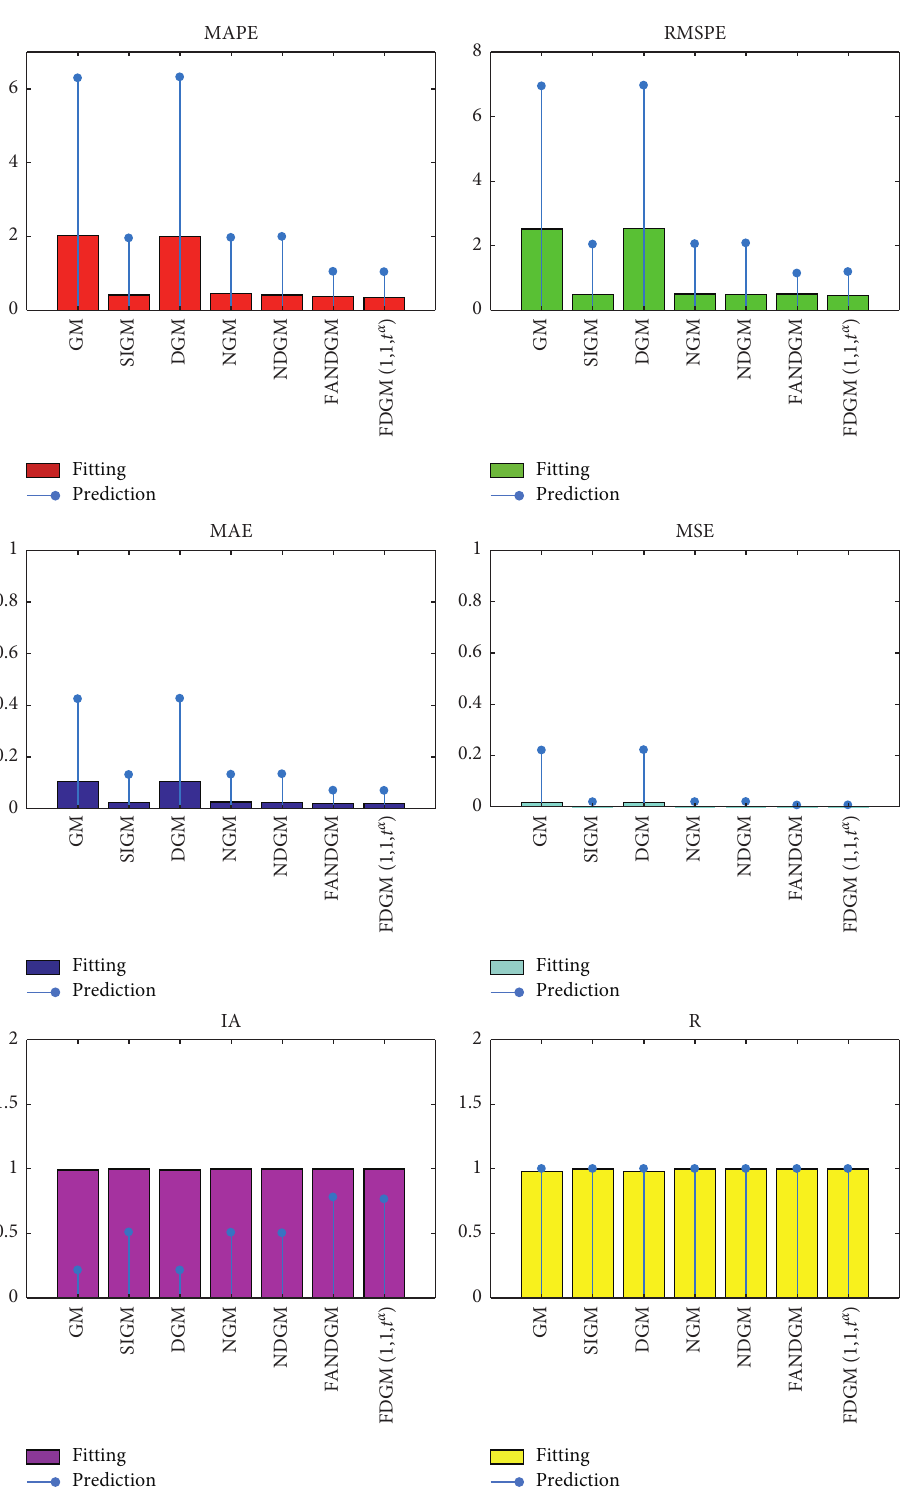
Figure 9: Error metrics of energy consumption of urban civil